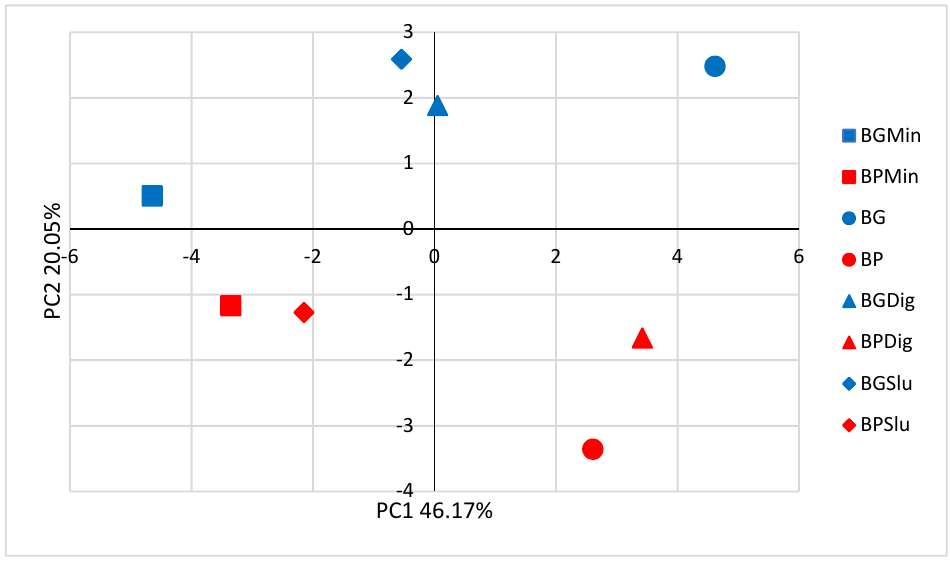
Figure 3. Principal component analysis (PCA) based one 24 soil fertility parameters (year 2018).